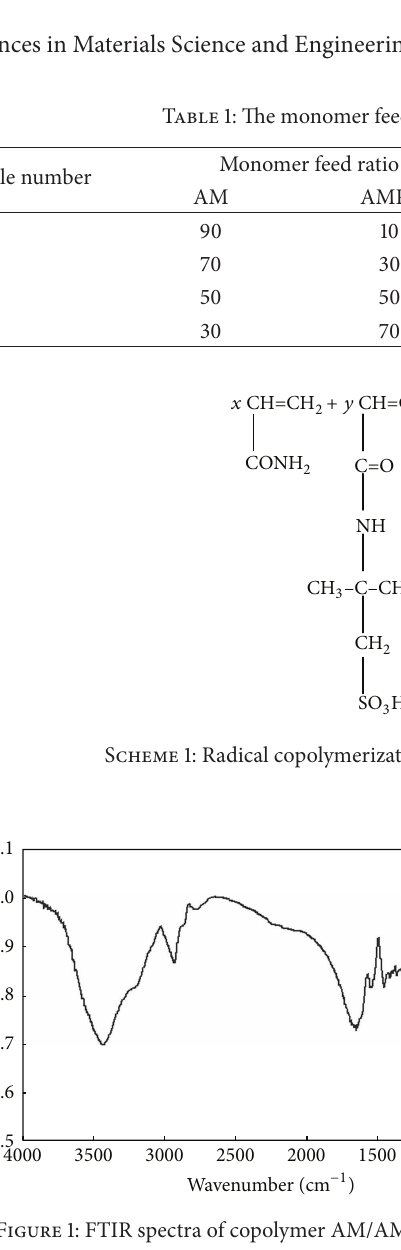
13 C-NMR typical copolymer: AM C=O 180.33